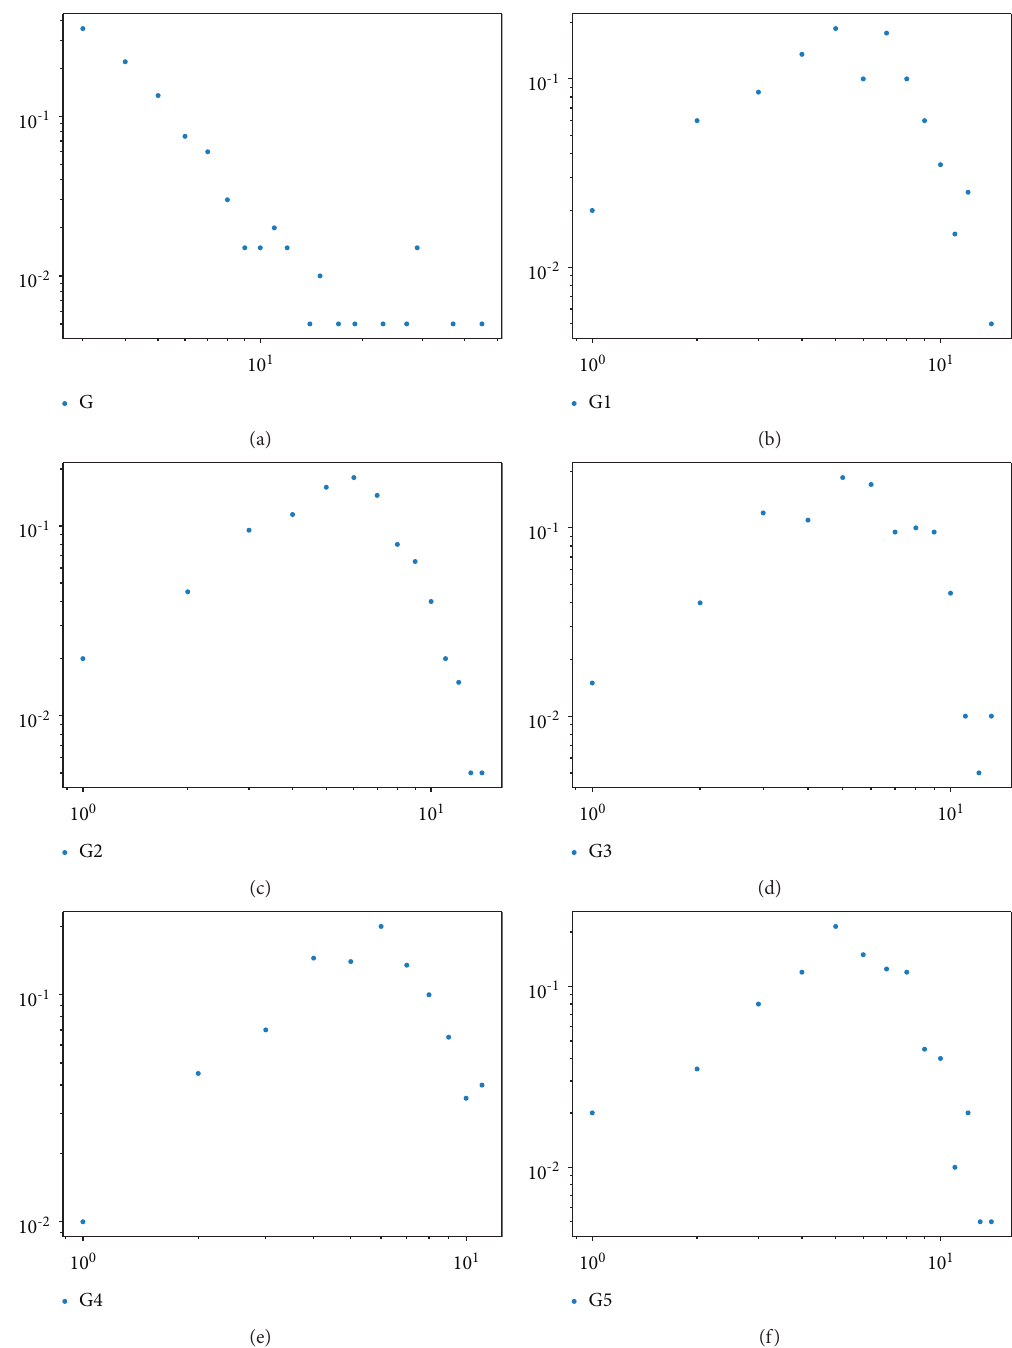
Figure 2: Comparison of degree distribution between Model B and BA, where G represents BA network and G1–G5 represents the comparison of different thresholds of Model B